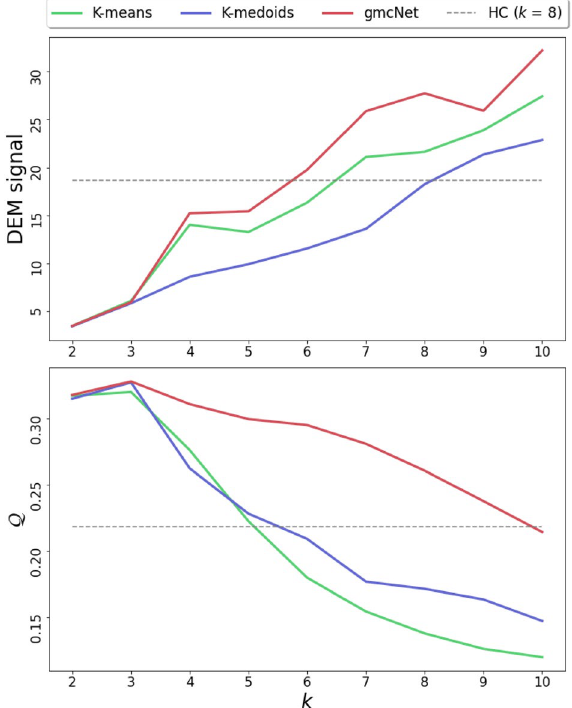
Figure 3. Optimal k searching considering DEM signaling and the modularity Q